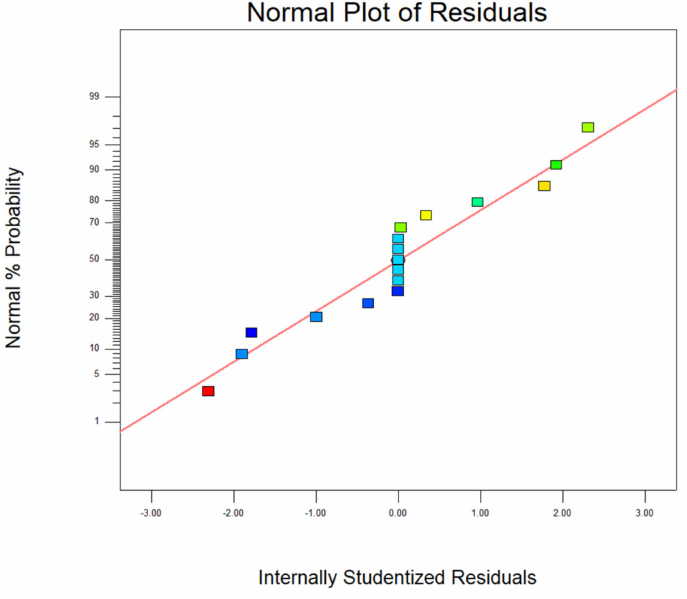
Figure 16. Normal plot of residual error.